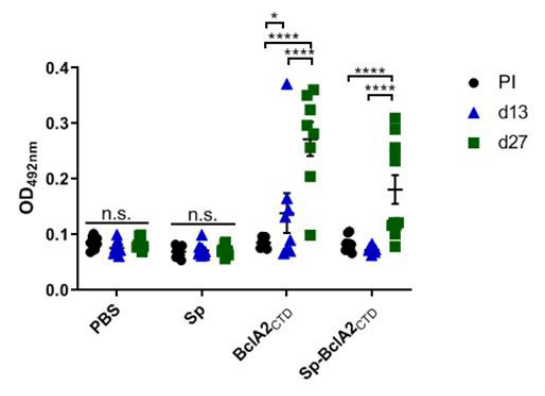
Figure 7. Immunogenicity of BclA2 CTD protein and Sp-BclA2 CTD in mice after nasal immunizations. IgG anti-BclA2 CTD levels were measured by ELISA in the serum of mice on days 0 (pre-immune serum, PI), 13 (d13), and 27 (d27) after the beginning of the experiment (one day before each immunization). Results are reported as optical density (OD) units at 492nm. The geometric mean (± standard error of the mean) for each group is shown. IgG titers of each group were compared between d0 (PI), d13, and d27 with one-way ANOVA Turkey’s multiple comparison tests, and statistical differences ( p < 0.05) are indicated by asterisks.